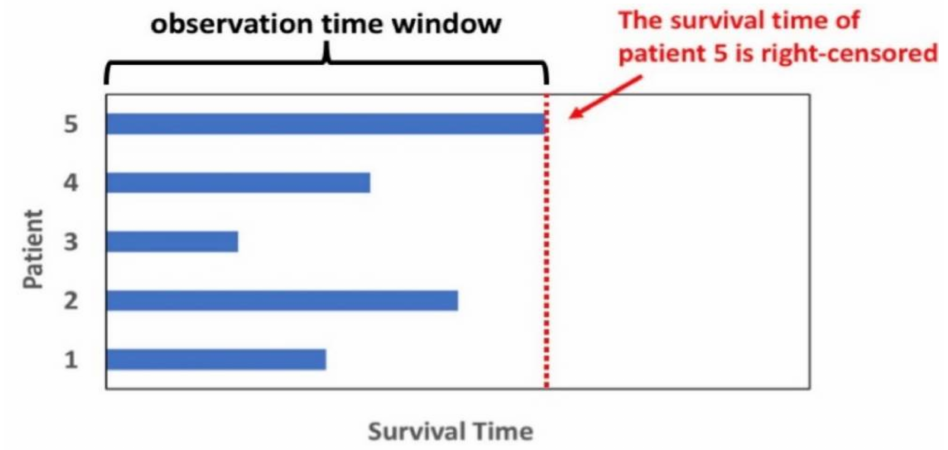
Figure 1. Subject’s survival status within an observation time window. Subject #5 survives at the end of the observation and the data is missing outside the monitor window